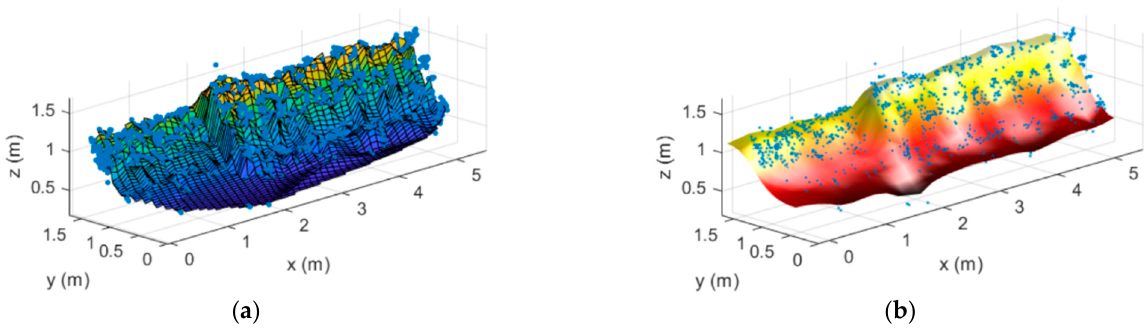
Figure 6. Surface reconstruction of the stockpile-alike model following ( a ) proc1 and ( b ) proc2 procedures. Table 1. Real and reconstructed dimensions of the stockpile.